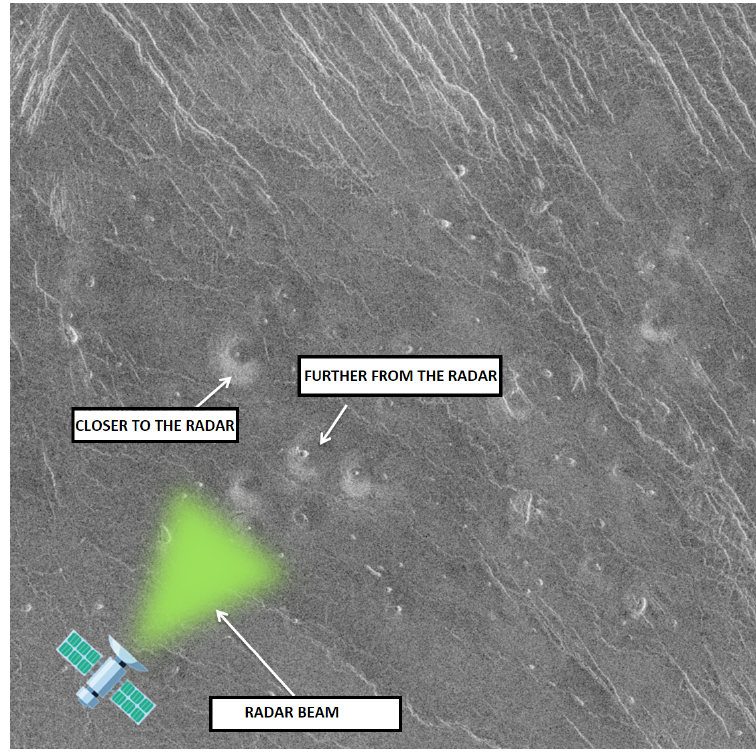
Figure 1. The example of a radar signature